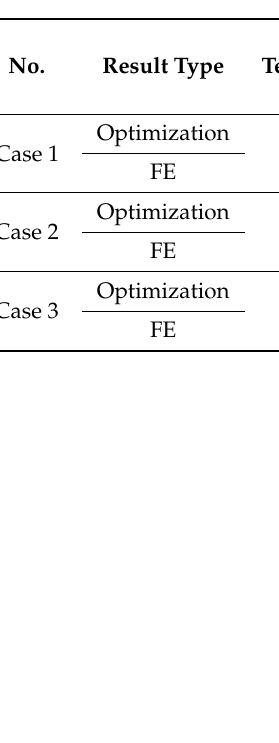
Figure 16. The Pareto optimal front by the MOPSO algorithm with ε -dominance.